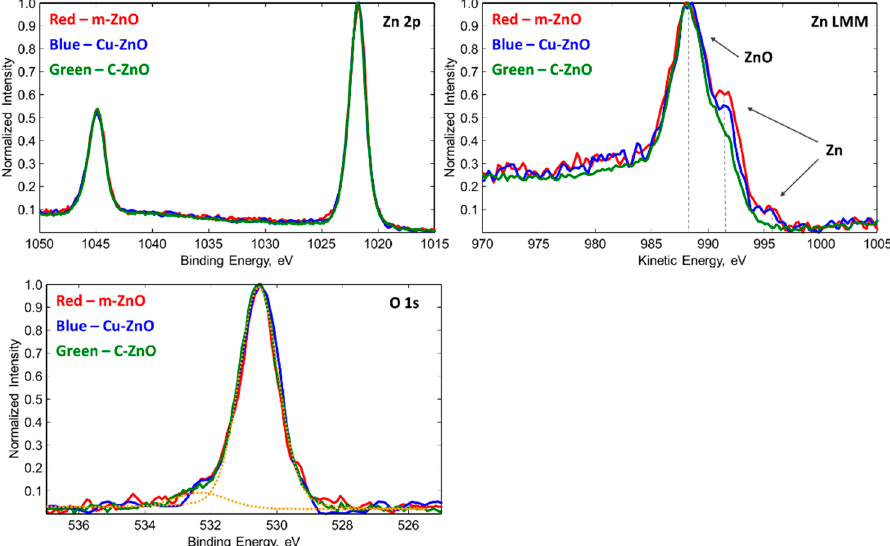
Figure 3. Comparison of Zn 2p, Zn LMM and O 1s electron spectra for m-ZnO (red curve), Cu-ZnO (blue curve), and C-ZnO (green curve) samples. Dotted orange lines in O1s spectra represents the fitting result for the C-ZnO sample, but nearly identical fit was obtained for all free samples. During XPS spectra acquisition (4.5 W, 20 µm focused beam size, 23.5 eV pass energy, 0.2 eV increment), charge neutralisation was realised by a dual neutralisation system consisting of low energy electron and ion beams. Adventitious carbon C 1s peak position of 284.8 eV was used as a neutral charge reference point.